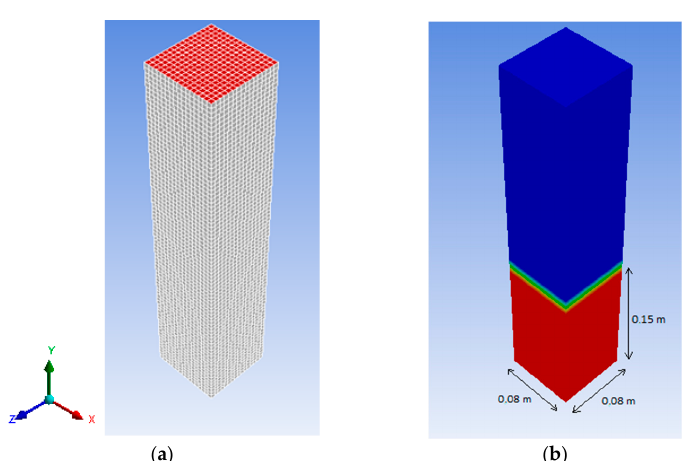
Figure 3. ( a ) Mesh setting for the computational domain; ( b ) representation of static bed. The original solid volume percentage of 0.6 is shown in red, while the freeboard is represented in